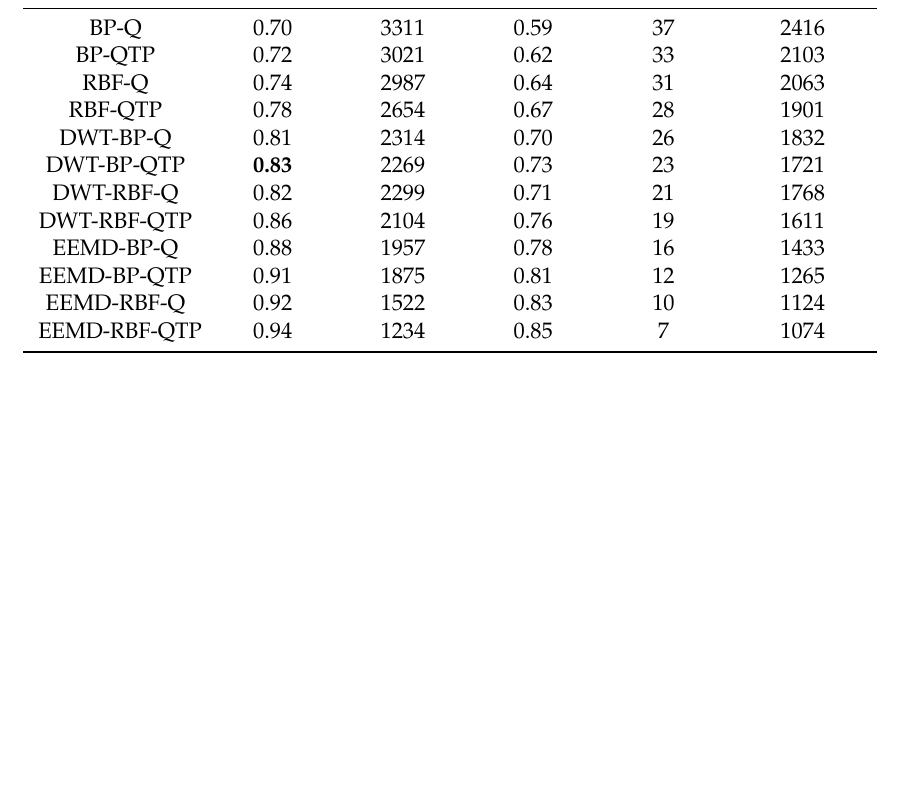
Table 7. Performance evaluation of the applied models for zone one during the validation period.